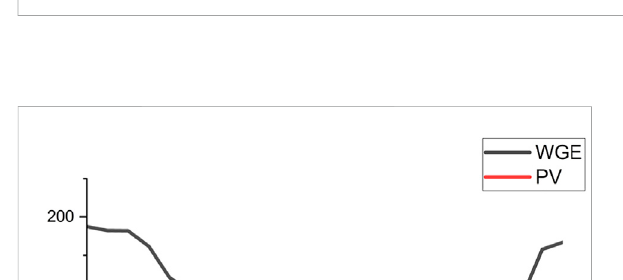
FIGURE 8 PJM-5 node system.